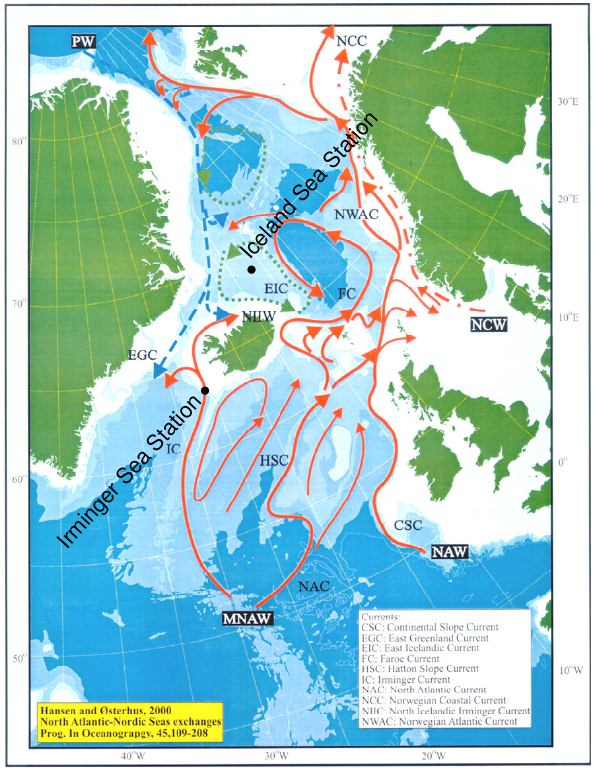
Figure 1. Locations of the Irminger Sea and the Iceland Sea time series stations inserted on the N-Atlantic surface current chart of Hansen and Østerhus